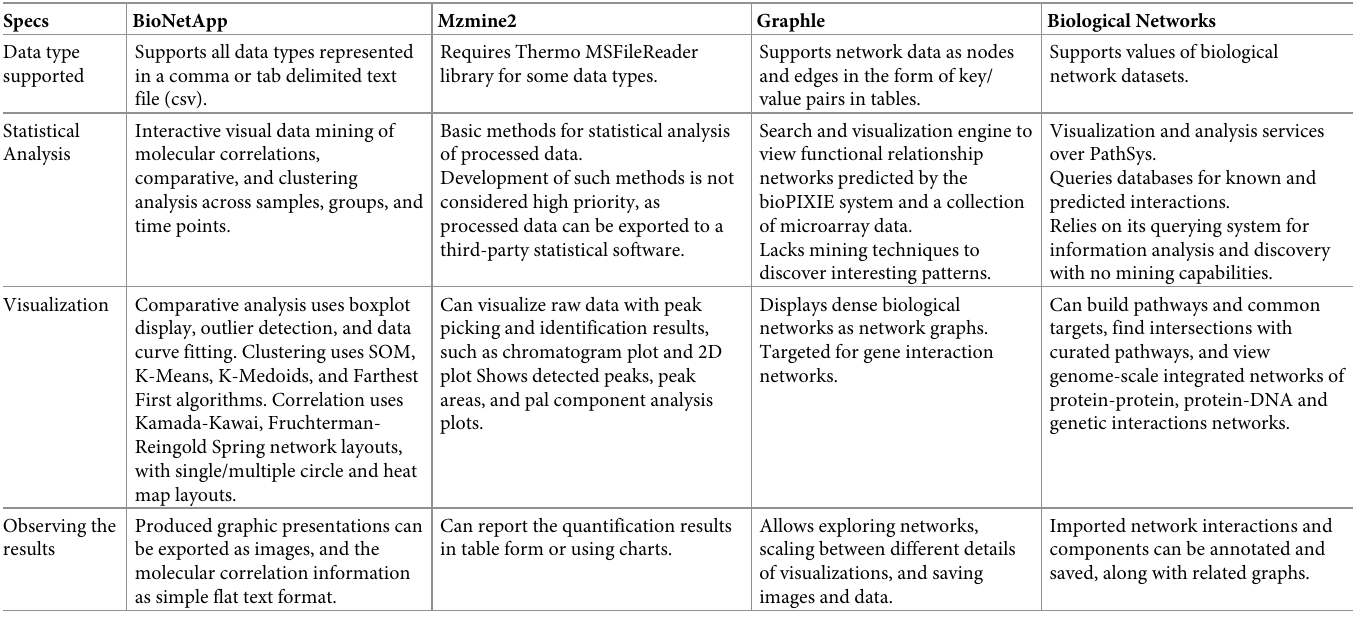
Table 1. A comparison between BioNetApp, Mzmine2, Graphle, and Biological